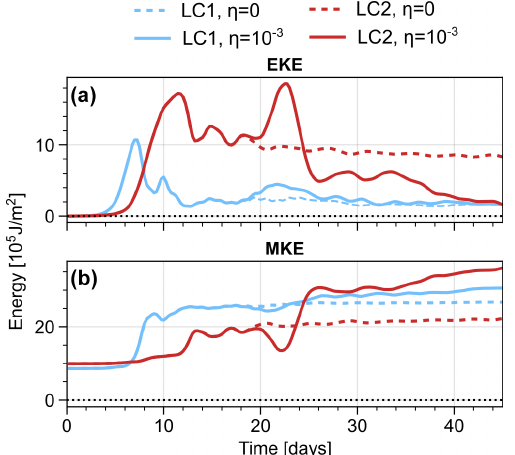
Figure 2. Evolution of (a) eddy kinetic energy and (b) mean ki- netic energy for LC1 and LC2 initialisations, each without ( η = 0, dashed) and with weak ( η = 10 − 3 , solid) initial noise. Energies are shown as northern-hemispheric horizontally averaged and vertically integrated energy